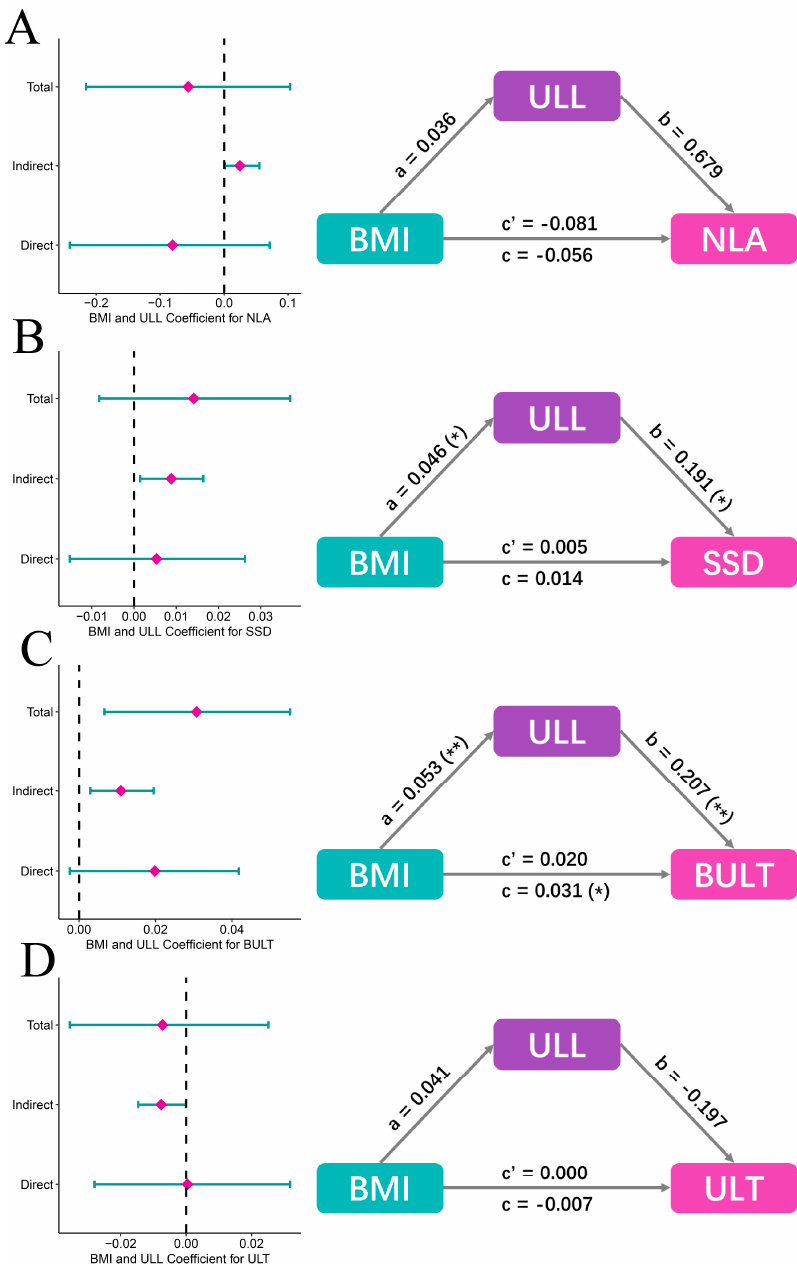
Figure 6. Mediation analysis among the four un-independent upper lip characteristics, ULL and BMI. ( A ) Mediation analysis model results of BMI, ULL and NLA (adjusted). Total effect ( − 0.056, p > 0.05) of BMI towards NLA consisted of direct effect ( − 0.081, p > 0.05) and indirect effect (0.025 = 0.036 × 0.679, p > 0.05). ( B ) Mediation analysis model results of BMI, ULL and SSD (adjusted). Total effect (0.014, p > 0.05) of BMI towards SSD consisted of direct effect (0.005, p > 0.05) and indirect effect (0.009 = 0.046 × 0.191, p = 0.018). ( C ) Mediation analysis model results of BMI, ULL and BULT (adjusted). Total effect (0.031, p = 0.014) of BMI towards BULT consisted of direct effect (0.020, p > 0.05) and indirect effect (0.011 = 0.053 × 0.207, p = 0.010). ( D ) Mediation analysis model results of BMI, ULL and ULT (adjusted). Total effect ( − 0.007, p > 0.05) of BMI towards ULT consisted of direct effect (0.000, p > 0.05) and indirect effect ( − 0.008 = 0.041 × ( − 0.197), p > 0.05). NLA: Nasolabial angle, SSD: Superior sulcus depth, BULT: Basic upper lip thickness, ULT: Upper lip thickness, ULL: Upper lip length, BMI: Body mass index. *: p < 0.05, **: p <